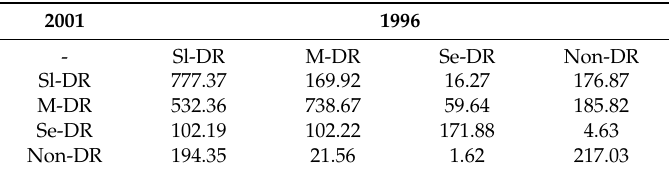
Table 5. Rangeland degradation changes (km 2 ) from 1996 to 2001 in Linxia rangeland.